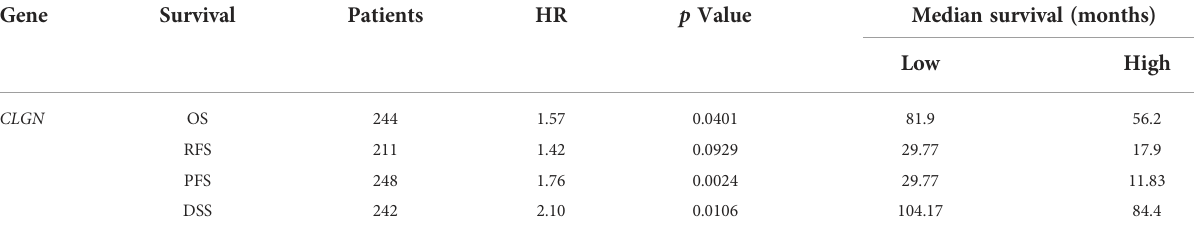
TABLE 1 Correlation between the CLGN mRNA expression and the survival of HCC patients.